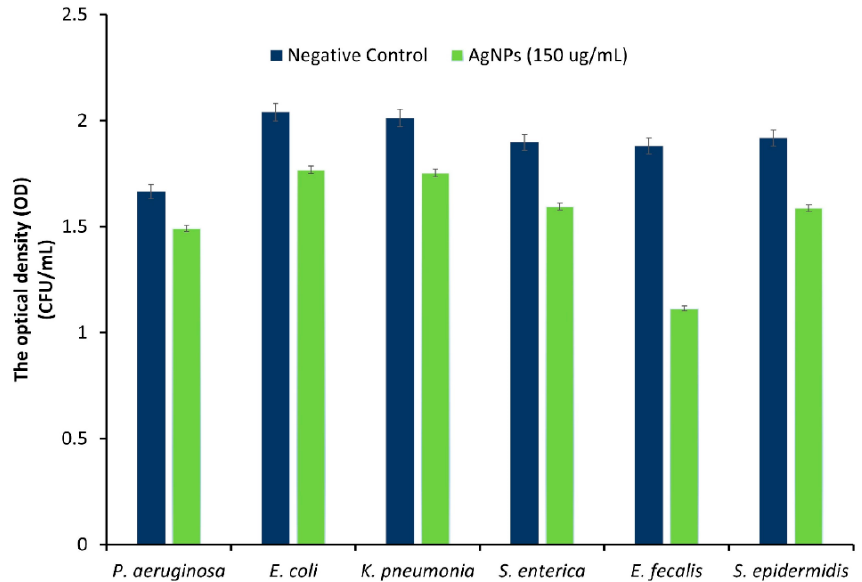
Figure 6. The ODs data for 150 µg/mL of AgNPs against P. aeruginosam , E. coli , K. pneumonia , S. enterica , E. fecalis , and S. epidermidis , after 24 h of incubating at 37 °C. The quantification of the total number of bacteria was done in triplicate.